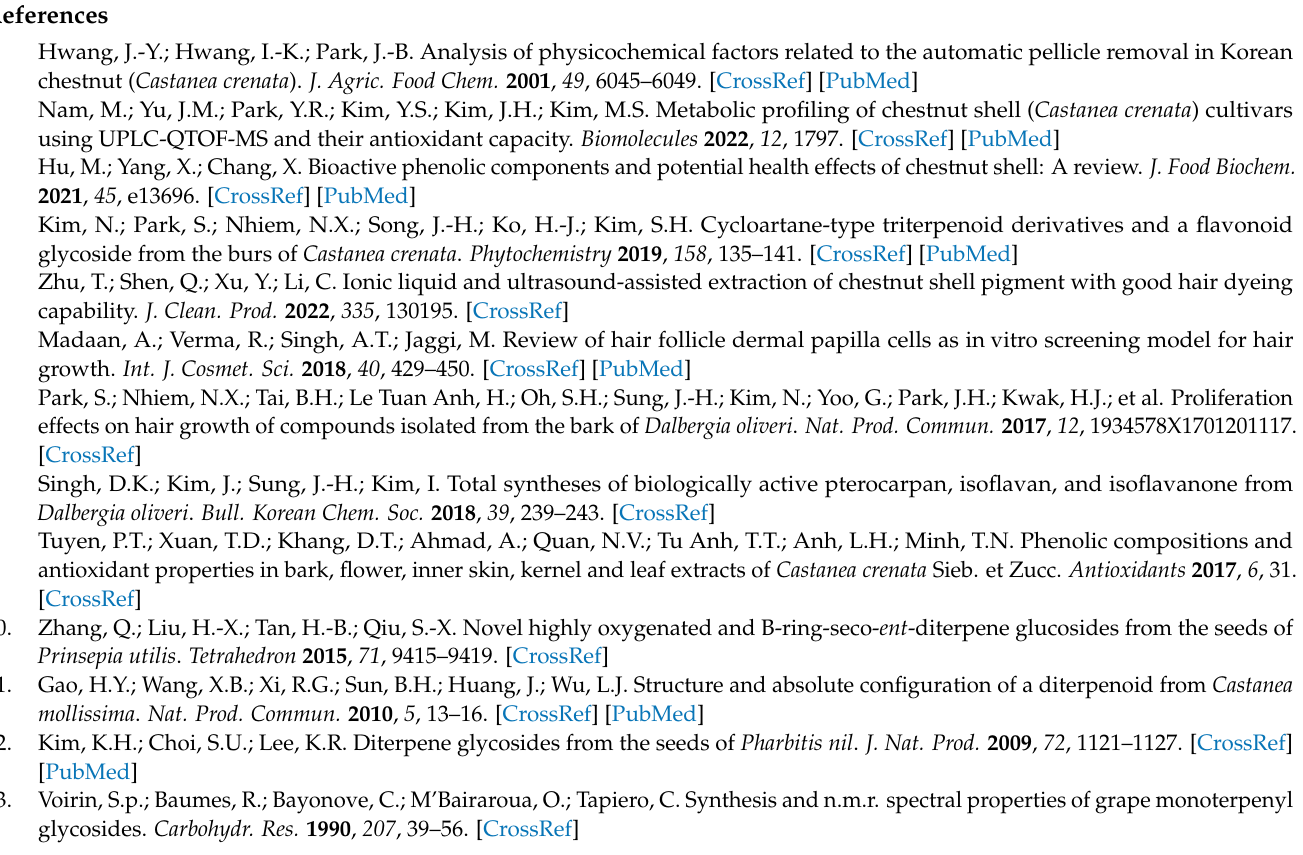
H-NMR spectrum of compound 1 ; Figure S3 13 C-NMR spectrum of compound 1 ; Figure S4 HSQC spectrum of compound 1 ; Figure S5 COSY of compound 1 ; Figure S6 HMBC of compound 1 ; Figure S7 HR-ESI-MS of compound 2 ; Figure S8 1 H-NMR spectrum of compound 2 ; Figure S9 13 C-NMR spectrum of compound 2 ; Figure S10 HSQC spectrum of compound 2 ; Figure S11 HMBC spectrum of compound 2 ; Figure S12 HR-ESI-MS of compound 6 ; Figure S13 1 H-NMR spectrum of compound 6 ; Figure S14 13 C-NMR spectrum of compound 6 ; Figure S15 HMBC spectrum of compound 6 ; Figure S16 HR-ESI-MS of compound 7 ; Figure S17 1 H-NMR spectrum of compound 7 ; Figure S18 13 C-NMR spectrum of compound 7 ; Figure S19 HR-ESI-MS of compound 8; Figure S20 1 H-NMR spectrum of compound 8 ; Figure S21 13 C-NMR spectrum of compound 8 ; Figure S22 HMBC spectrum of compound 8